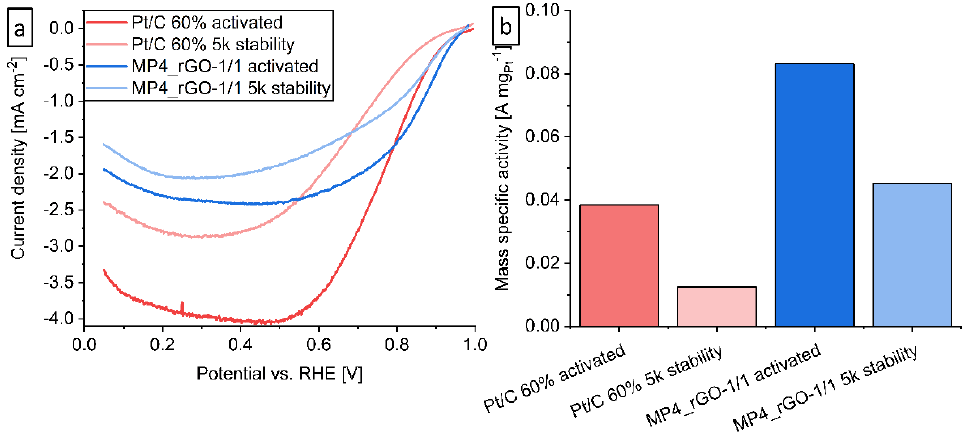
Figure 5. Electrochemical activity of the sample MP4_rGO-1/1 and Pt/C 60% as reference: ( a ) ob- tained linear sweep voltammetry at 10 mV s –1 sweep rate after the activation and after 5k cycles; ( b ) calculated mass-specific activity at 0.9 V after activation and after 5k cycles.